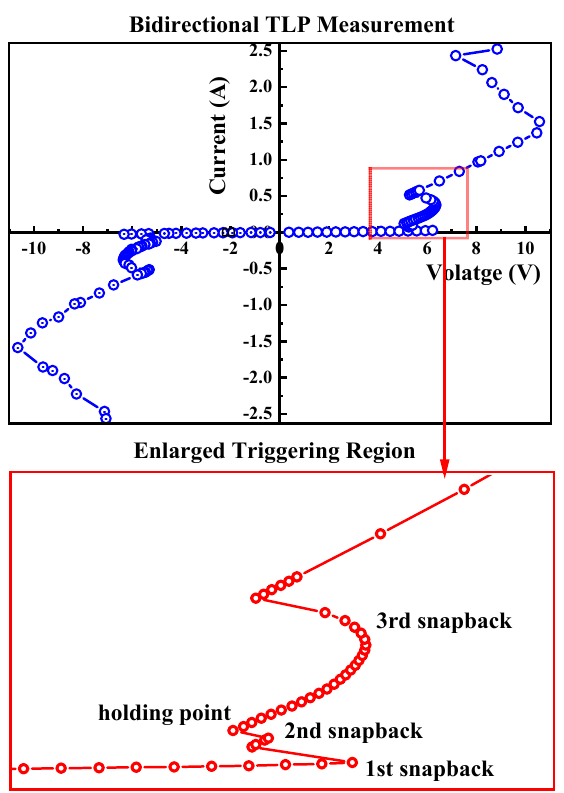
caused by the turn-on of the PNPN structure. As shown in Figure 3d, the current flow through R2 generates a voltage drop across the PW1 and turns on the parasitic NPNP Figure 2. TLP I-V curve for the PTBSCR (L = 0.5 µ m) when T1/T2 is subject to a positive ESD stress, structure, (composed of N1+, PW1, NW2, and P3+), Thus, the third snapback happens due Figure 2. TLP I-V curve for the PTBSCR (L = 0.5 μ m) when T1/T2 is subject to a positive ESD stress, to the turn-on of the NPNP structure. the T2/T1 and G are grounded. Enlarged figures: detailed triggering behaviors for the device. the T2/T1 and G are grounded. Enlarged figures: detailed triggering behaviors for the device.